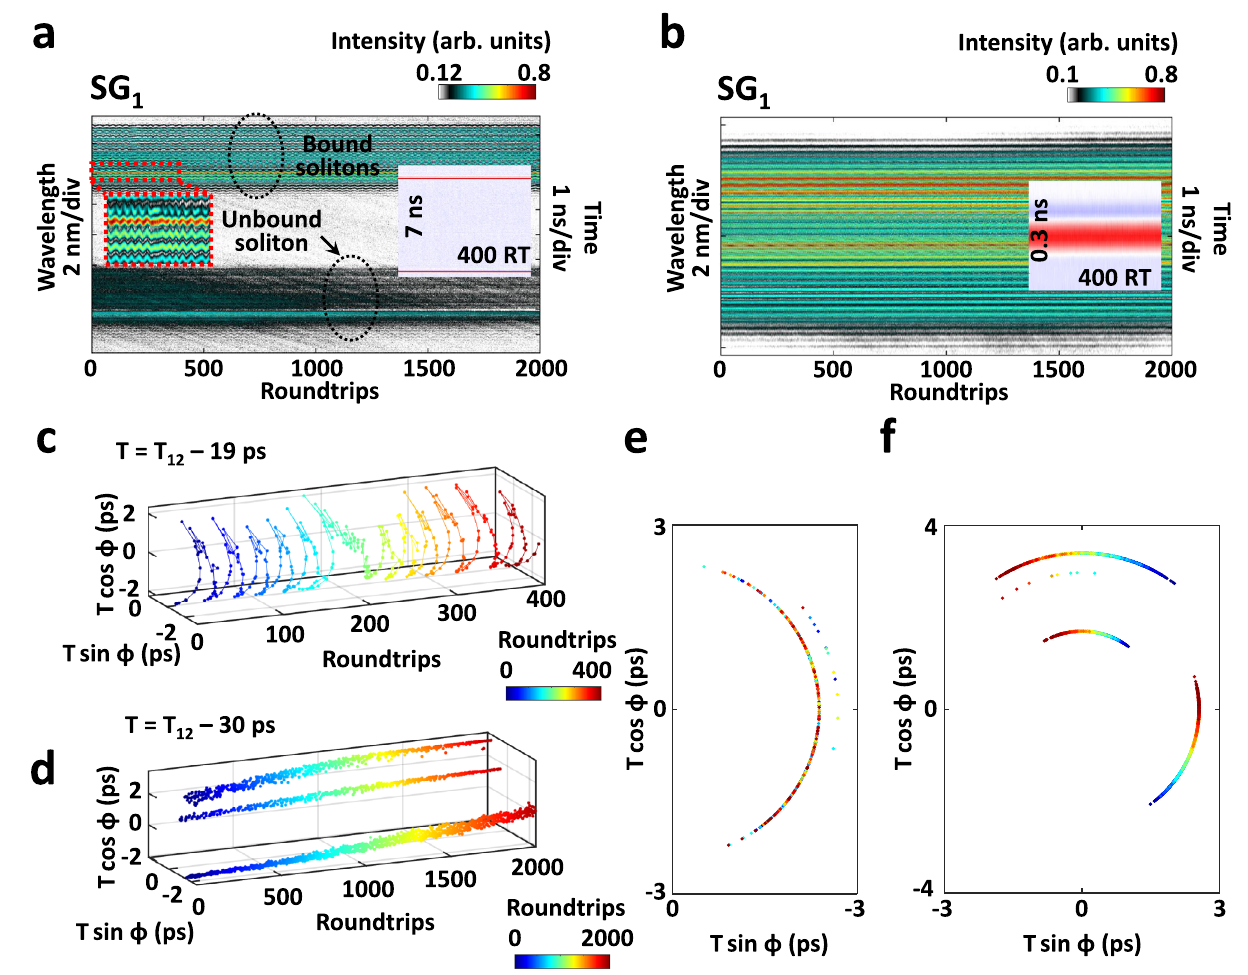
Fig. 7 | Relatively stable 3D multi-soliton molecules with different vibration patterns. a , b Spectral evolutions of two relatively stable 3D multi-soliton mole- cules in SG 1 . Here, these two 3D soliton molecules exhibit different temporal